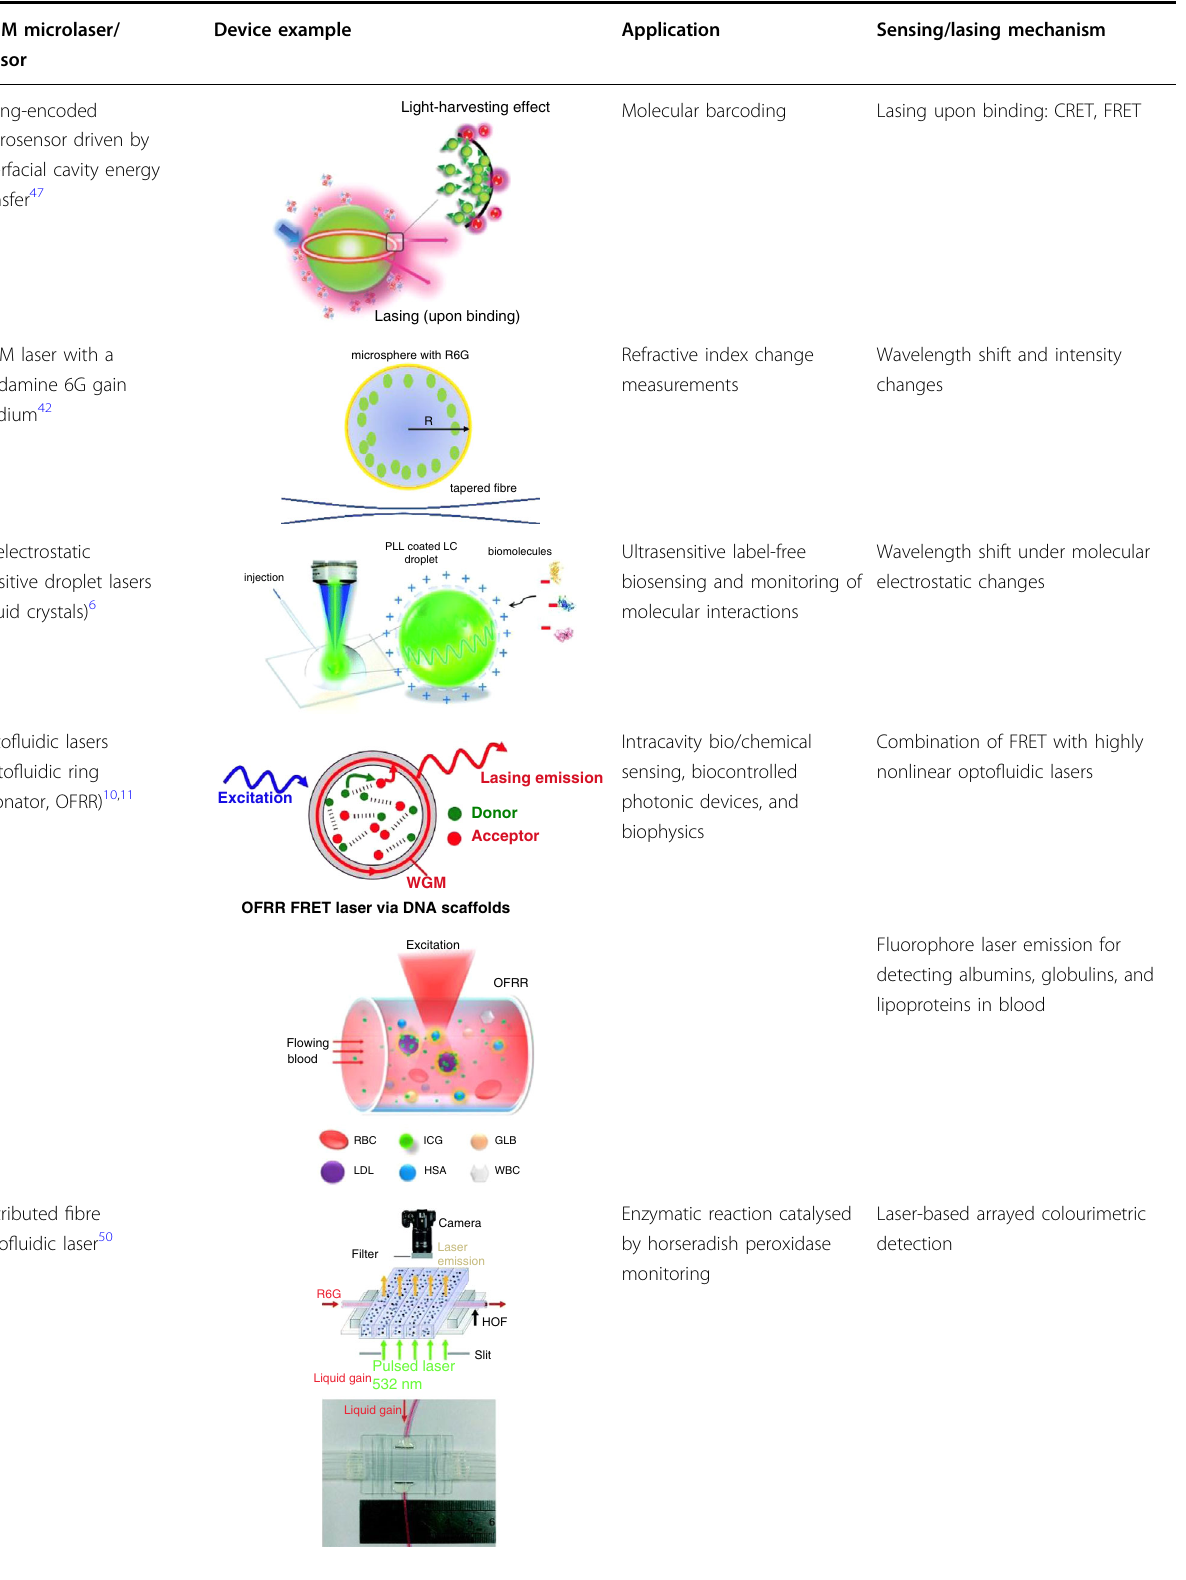
Table 1 WGM laser-based biosensors and their physical sensing